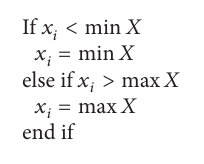
Algorithm 1: Particle position clamping.